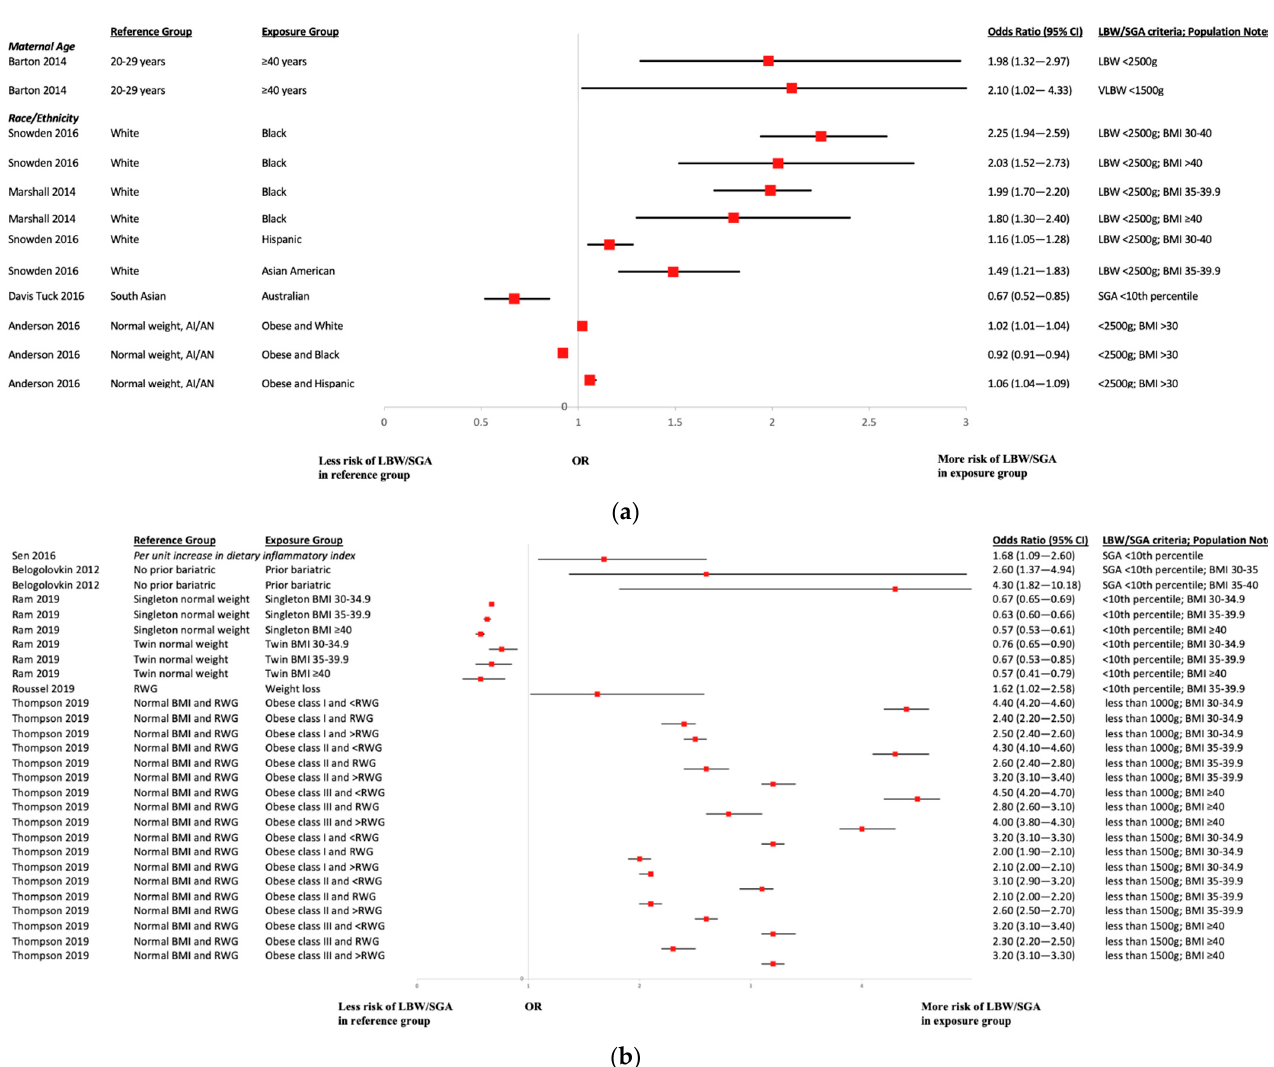
Figure 4. ( a ) LBW Age and Race. Acronyms: BMI = body mass index; LBW = low birth weight; VLBW = very low birth weight; AI/AN = American Indian/Alaskan Native; SGA = small-for-gestational-age; CI = confidence interval. ( b ) LBW Risk Factors. Acronyms: BMI = body mass index; LBW = low birth weight; VLBW = very low birth weight; RWG = recommended weight gain; SGA = small-for-gestational-age; CI = confidence interval.